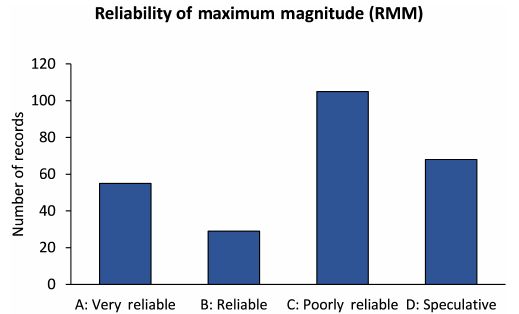
Figure 6. Distribution of rating levels for the database field reliabil- ity of recurrence interval (RRI) in QAFI v.3 database. See text for